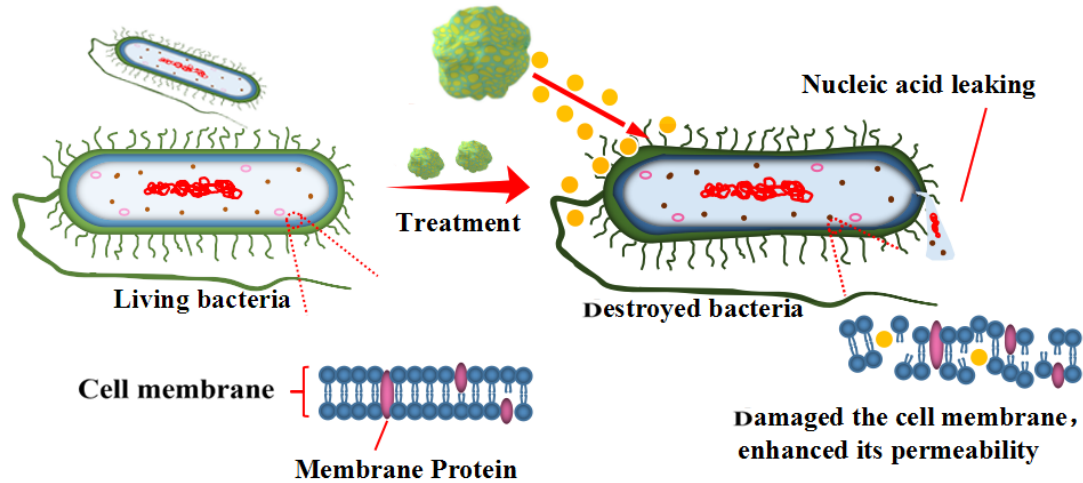
Figure 11. Schematic diagram of antibacterial mechanism of CEO-SNP.